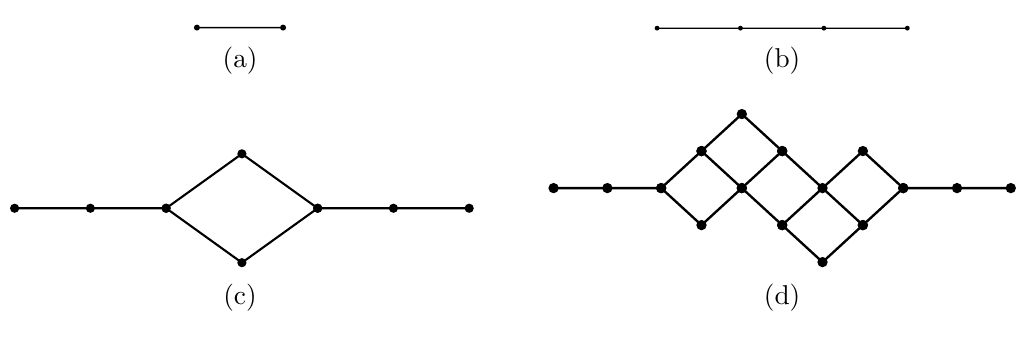
Figure 6 . There is a recurrence of one of the diagrams for each N mod 4. (a) N = 4 m (cid:0) 3, (b) N = 4 m (cid:0) 2, (c) N = 4 m (cid:0) 1, and (d) N = 4 m , ( m (cid:21) 1)